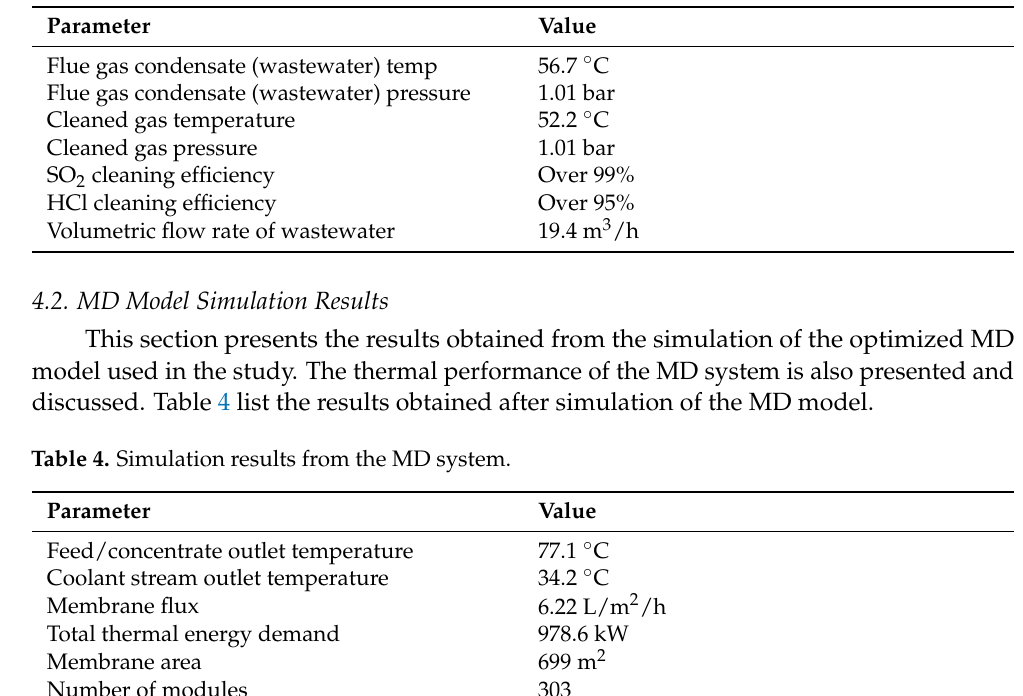
Table 3. Simulation results from the wet scrubbing process.